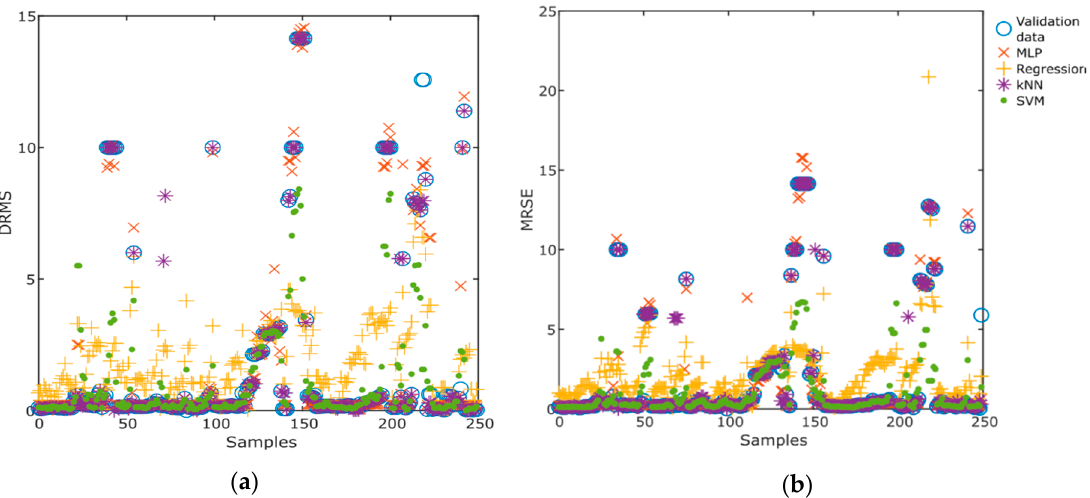
Figure 8. Behavior of LiDAR error of each model with regard to the validation data, ( a ) on the plane (DRMS) and ( b ) space (MRSE).